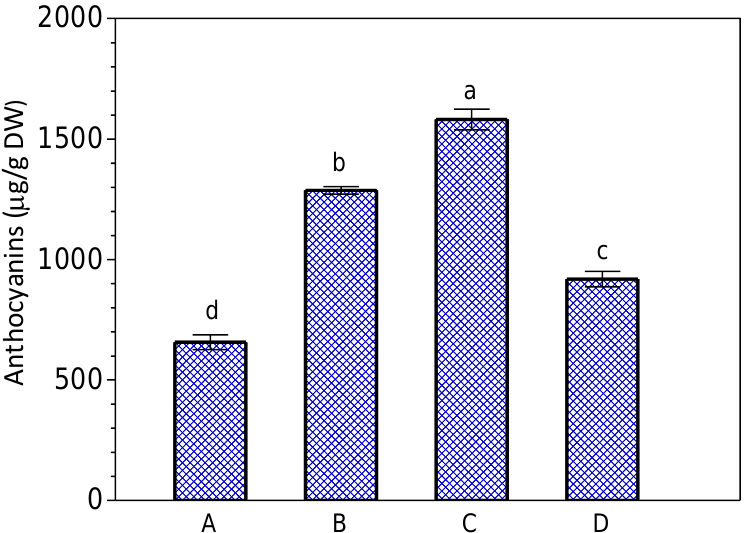
Figure 8. Effect of methyl jasmonate (JA-Me) applied in lanolin paste on the middle part of the excised leaves of K. blossfeldiana on total anthocyanin content. A—leaves on the plant; B—leaves kept in the detached position; C0—leaves stored in the inverted position and treated with pure lanolin; C1, C2, C3, and C4—leaves stored in the inverted position and treated with 1% JA-Me, 0.5% JA-Me, 0.25% JA-Me, or 0.1% JA-Me in lanolin paste, respectively. Mean results ± standard deviation followed by the same lower letter were not significantly different ( p < 0.05) according to Tukey’s test.